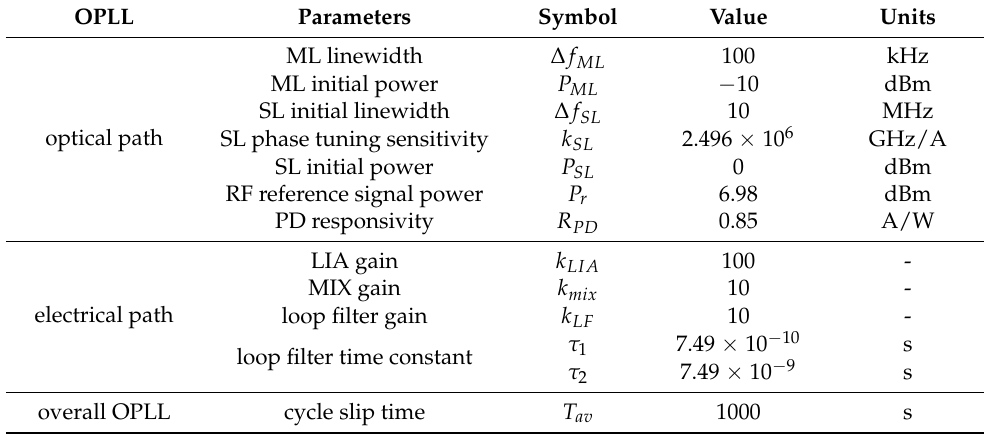
Table 1. OPLL design parameters.